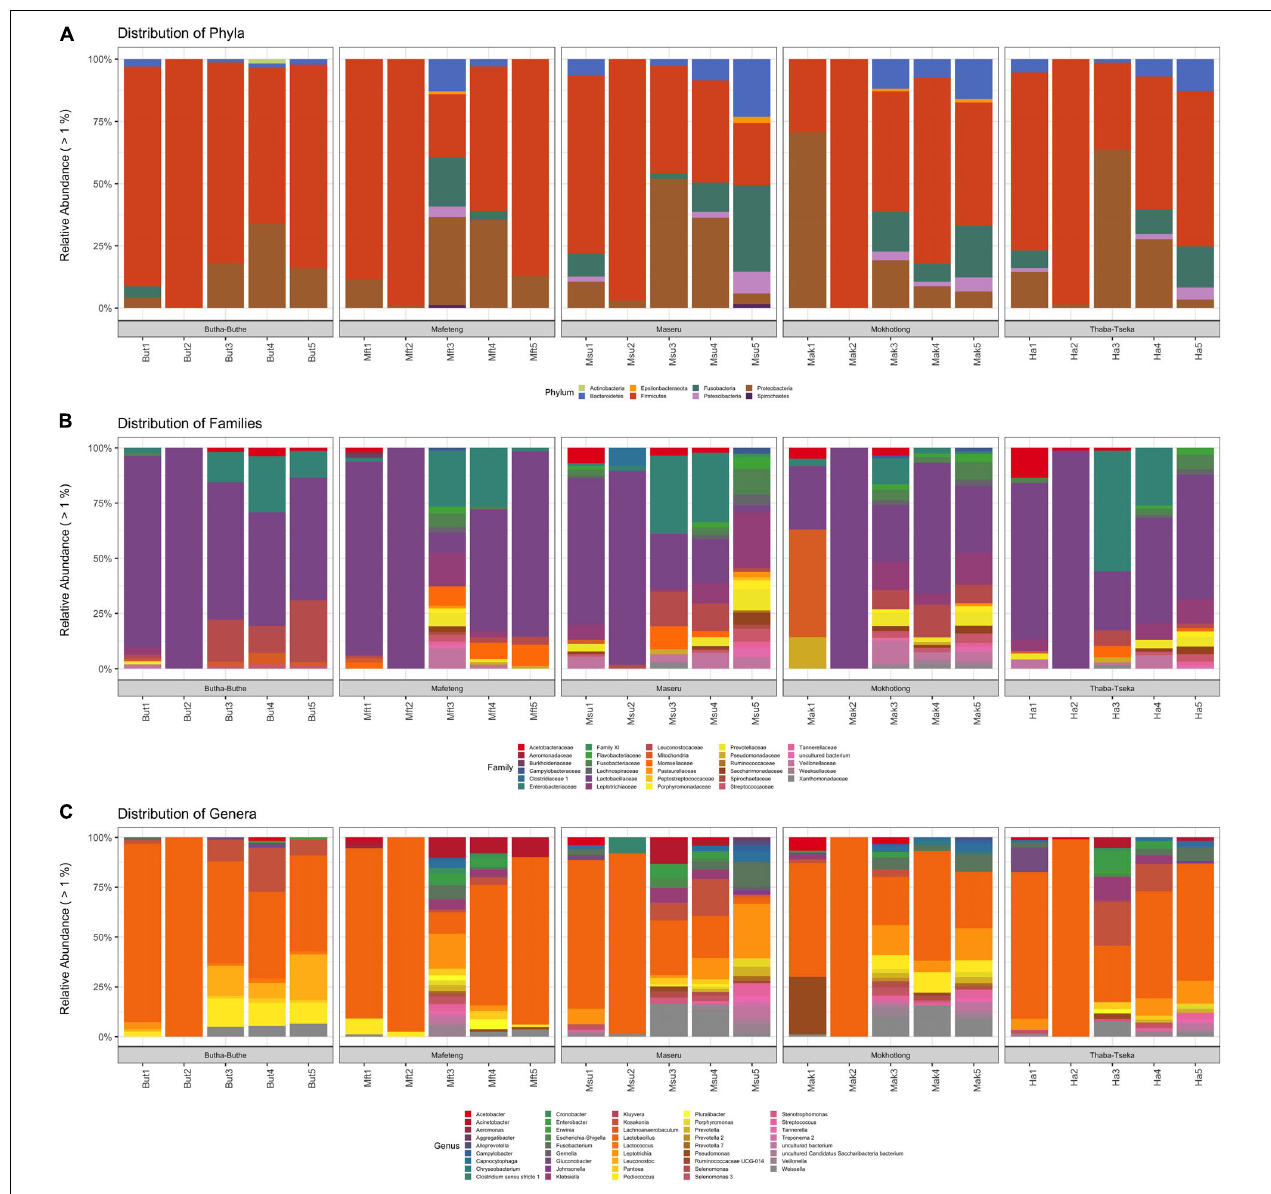
FIGURE 2 | Distribution of bacterial taxa in Sesotho . (A) Phylum, (B) Family, and (C) Genus level.